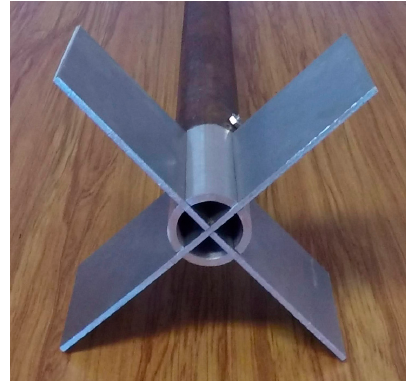
Figure 12. Aluminium fin set up.